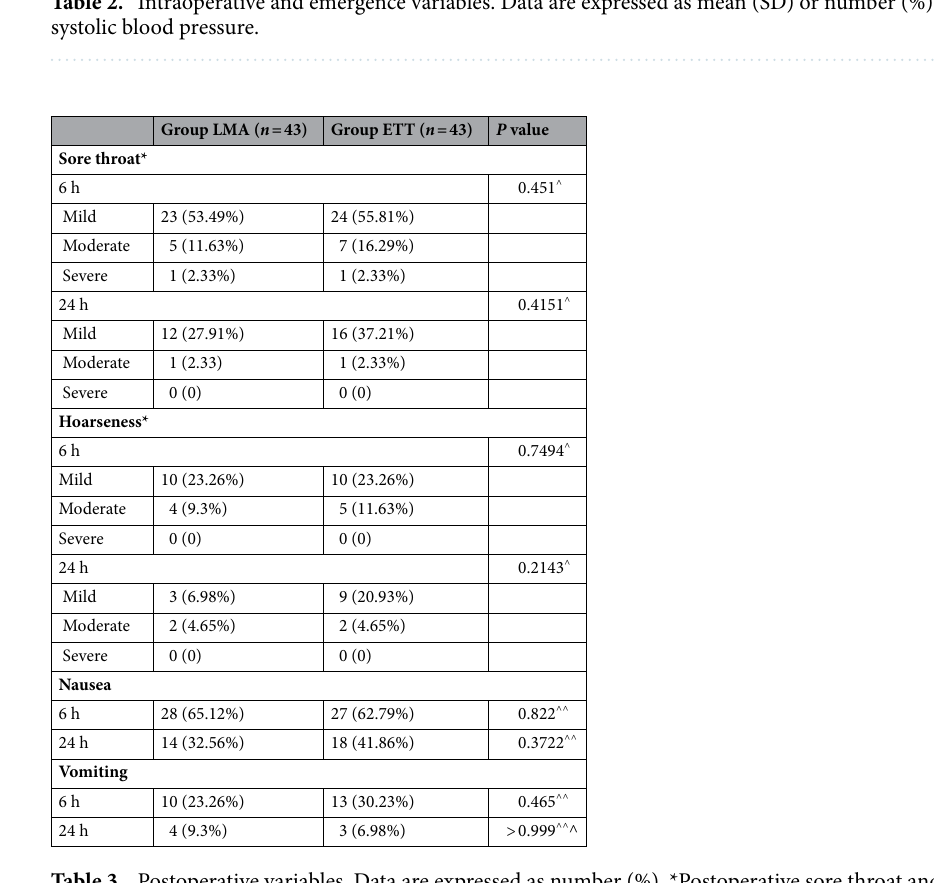
Table 3. Postoperative variables. Data are expressed as number (%). *Postoperative sore throat and hoaresness were presented as grading of discomfort. ^ P value, analysis of Cochran-Armitage trend test. ^^ P value, analysis of Chi-squred test. ^^^ P value, analysis of Fisher’s exact